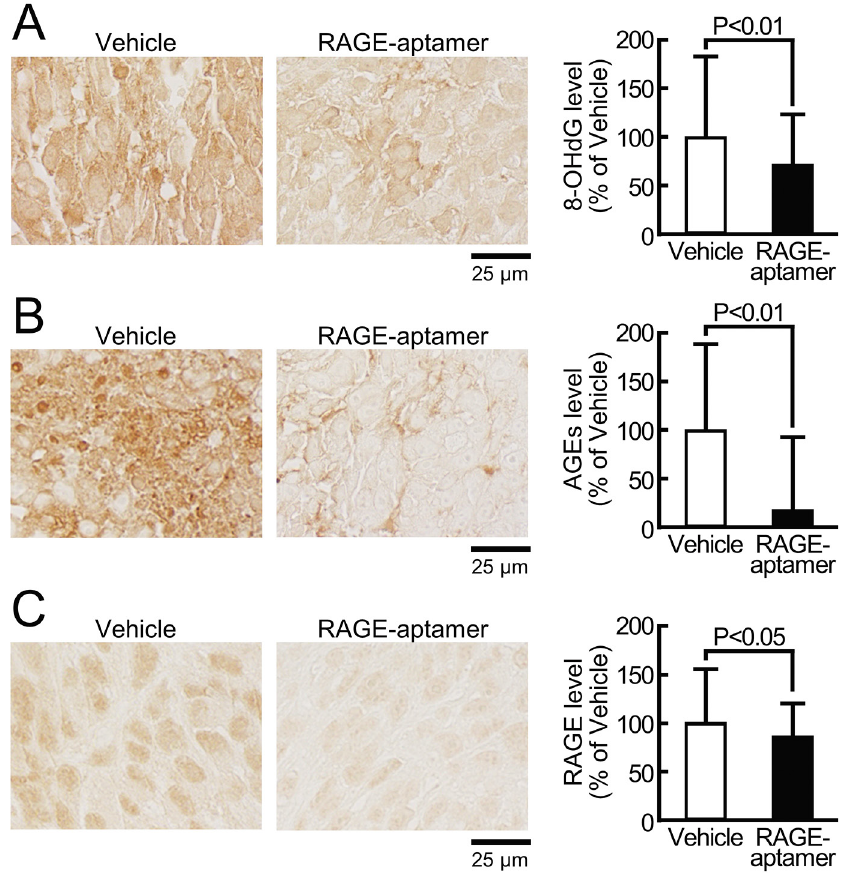
Figure 3. Effects of RAGE-aptamer on immunostaining of (A) 8-OHdG, (B) AGEs and (C) RAGE in G361 tumors. (A–C) Each left panel shows representative photographs of immunostaining. Quantitative data are shown in each right